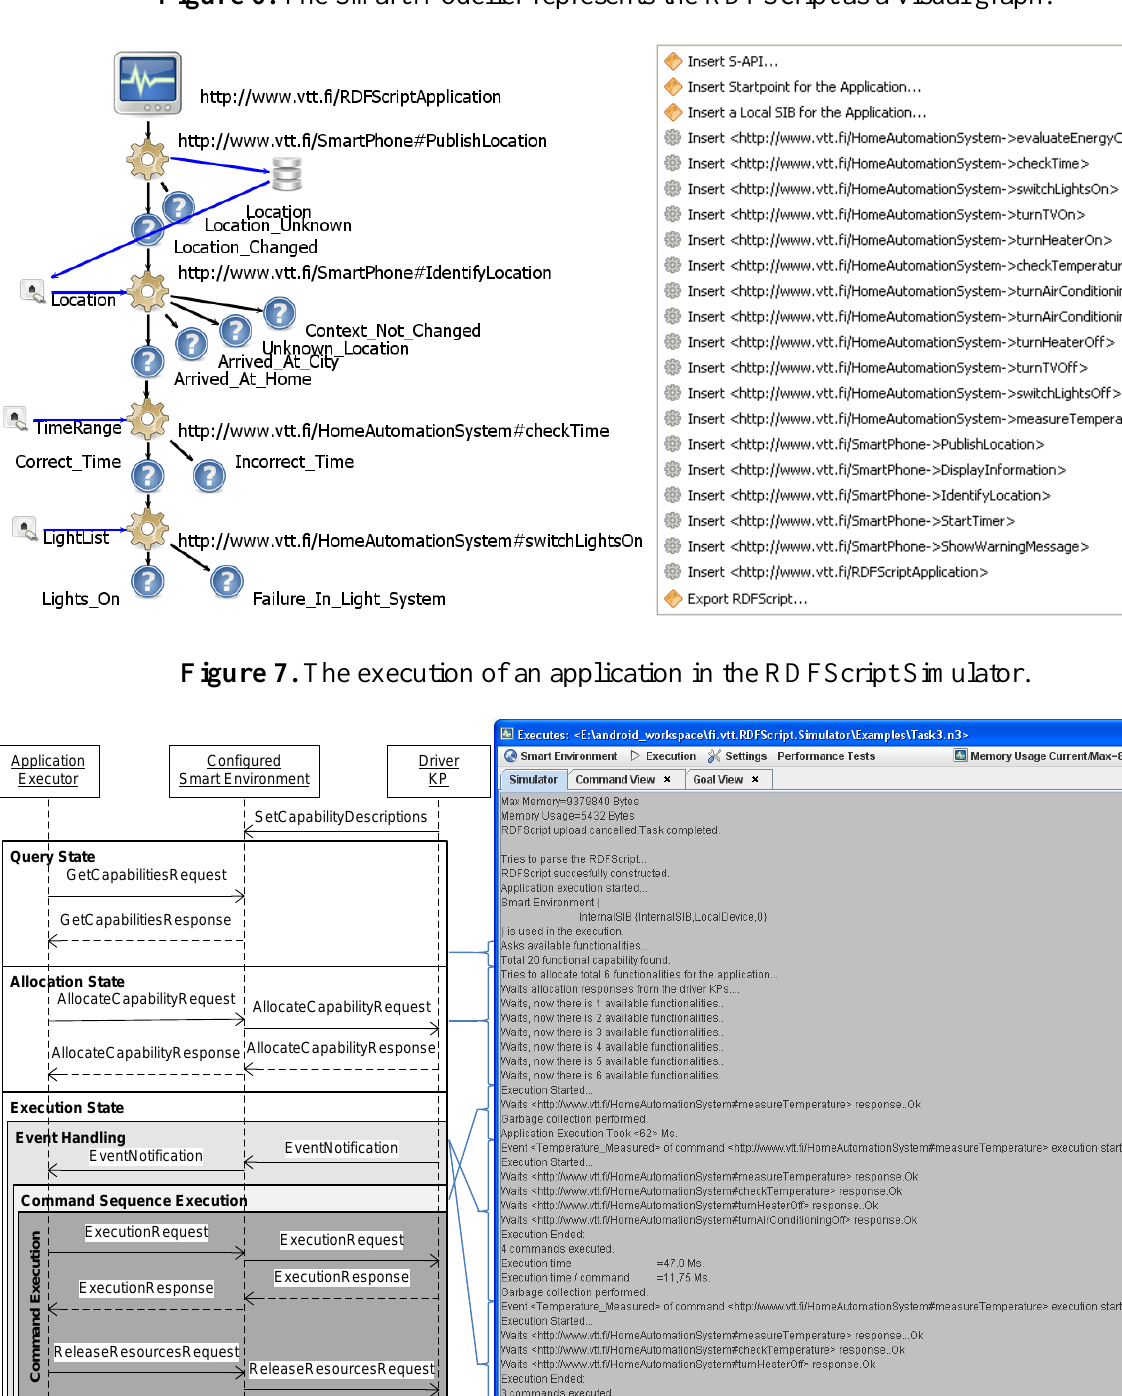
Figure 6. The Smart Modeller represents the RDFScript as a visual graph.